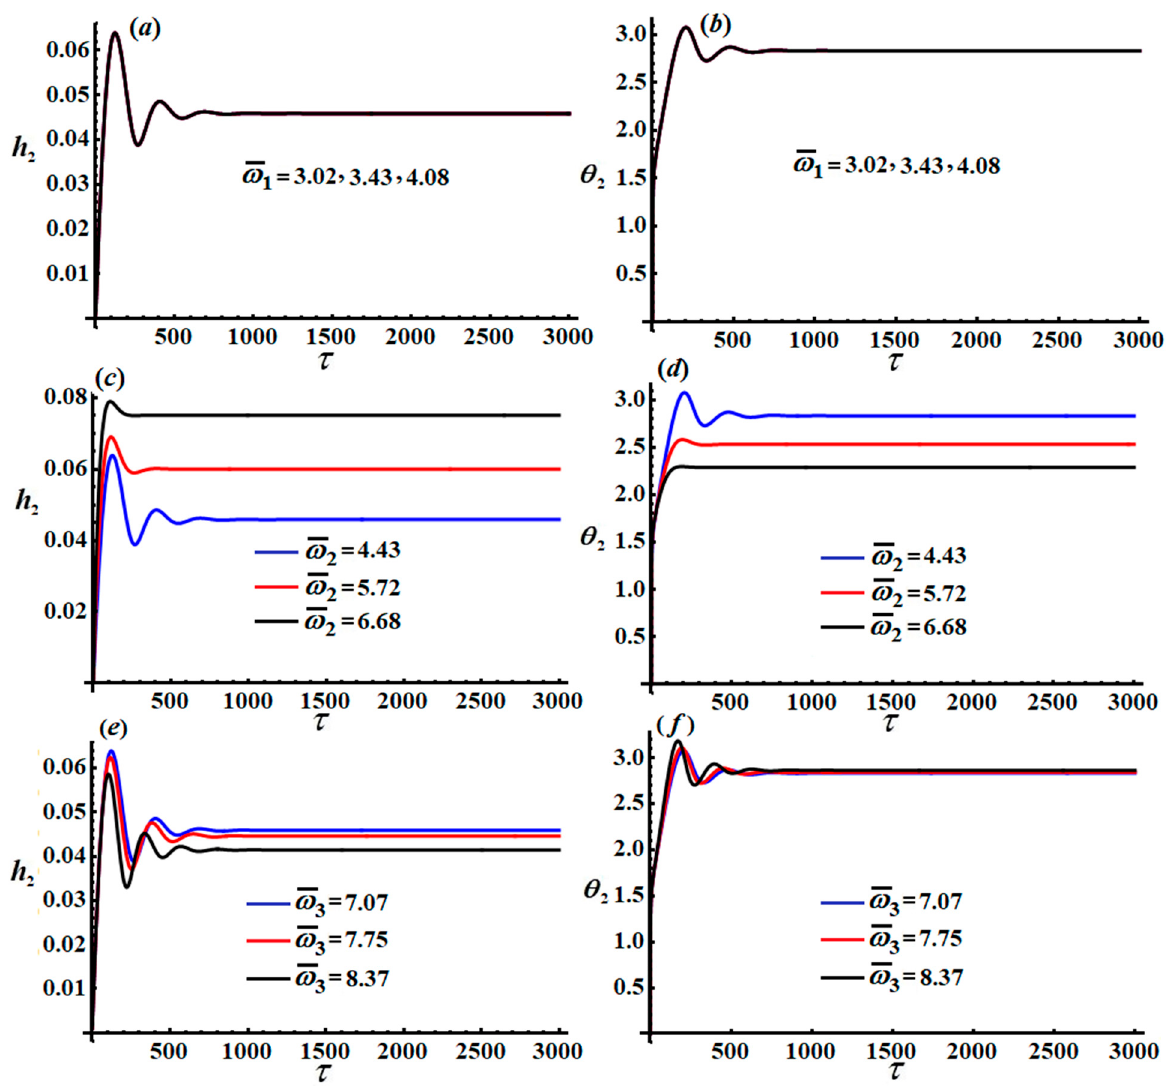
Figure 3. The variation of h ( e , f ) at ω 3 = ( 7.07,7.75,8.37 )